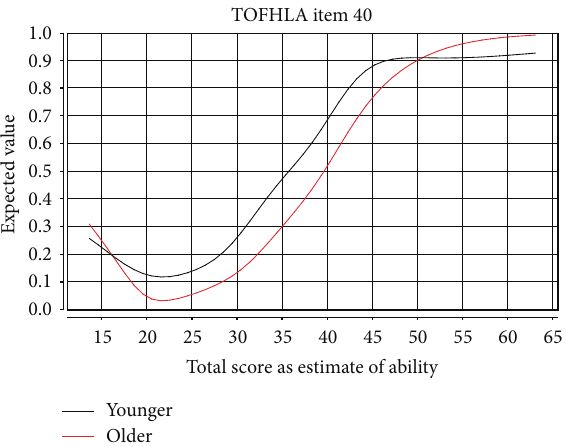
Figure 1: Item curve illustrating DIF between younger and older